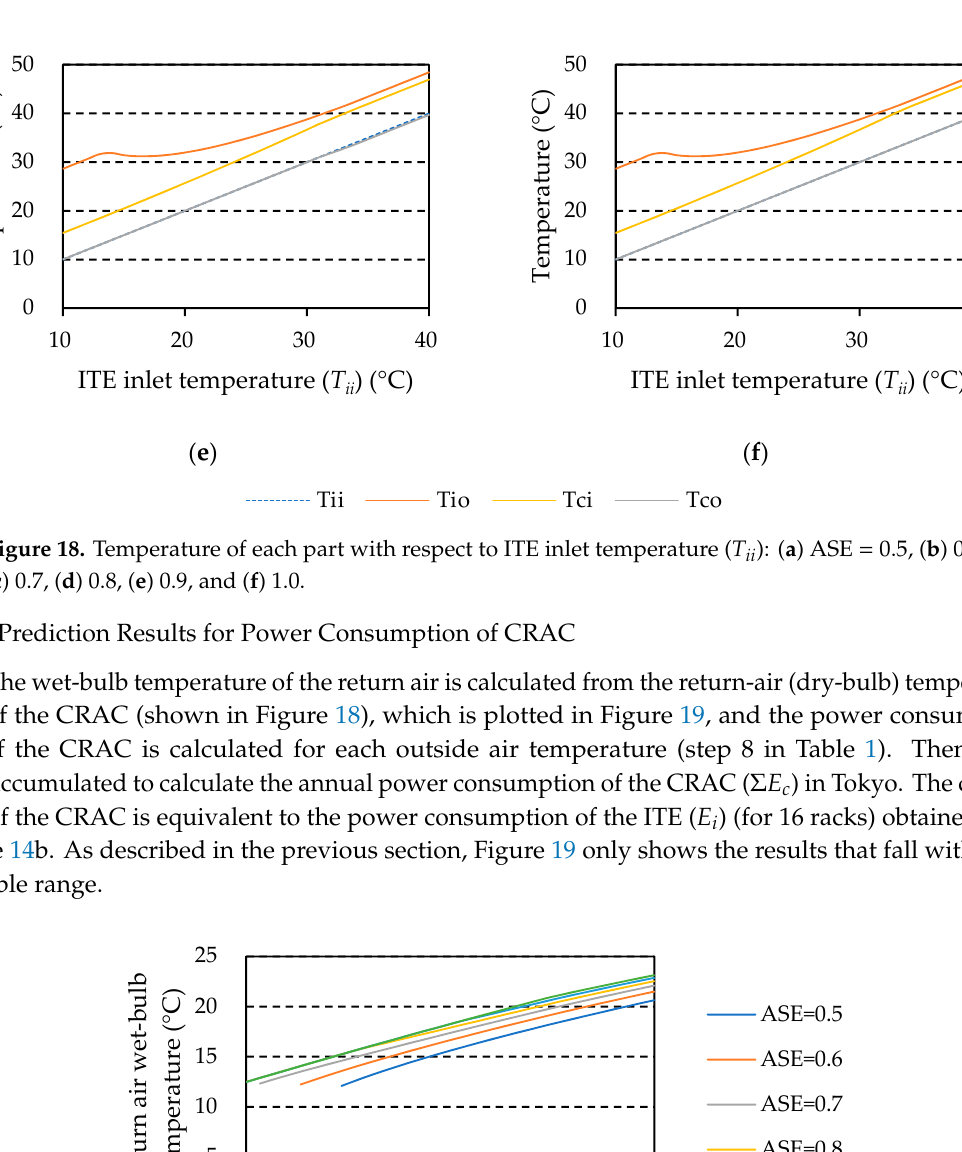
Figure 20. Annual power consumption of CRAC ( Σ E c ) versus ITE inlet temperature ( T ii ).